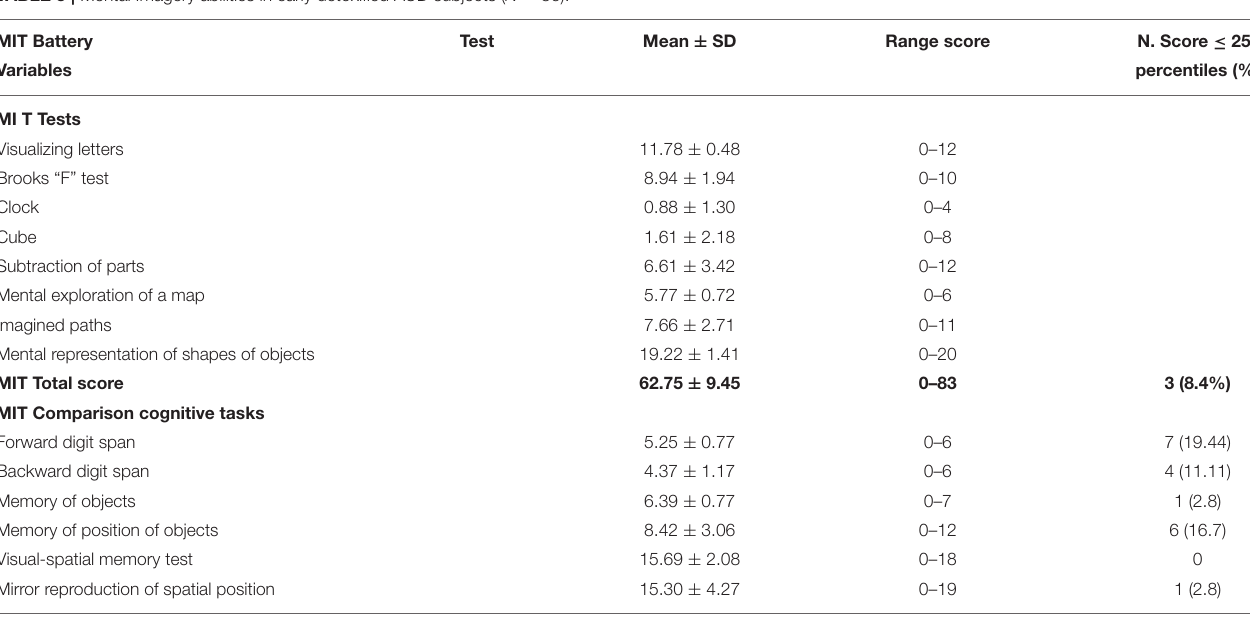
TABLE 3 | Mental Imagery abilities in early detoxified AUD subjects ( N =